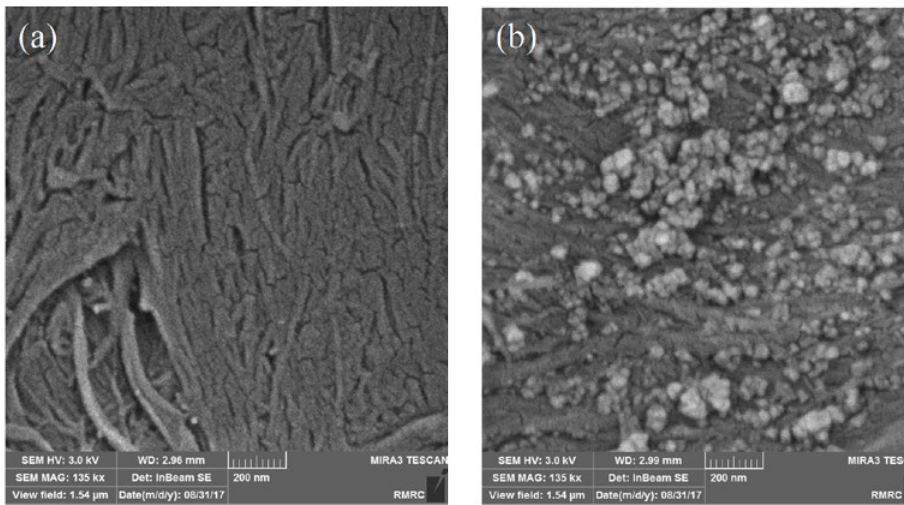
Fig: 4. FE-SEM micrographs for (a) untreated Spruce sawdust (SD) and (b) SD/MgO Fig. 4. FE-SEM micrographs for (a) untreated Spruce sawdust (SD) and (b) SD/MgO.